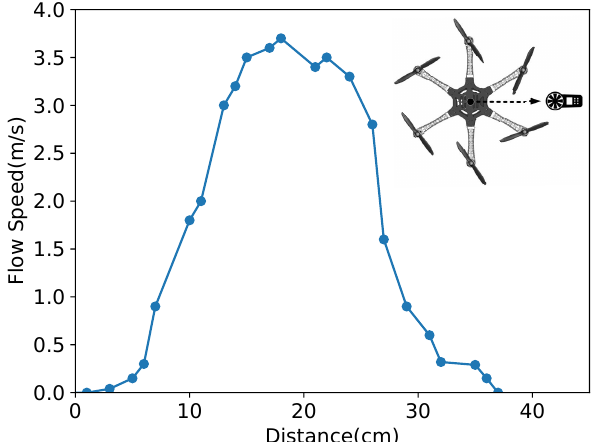
Figure 10. The flow speed measured by digital anemometer and the subfigure in the top right corner is the path of the anemometer during